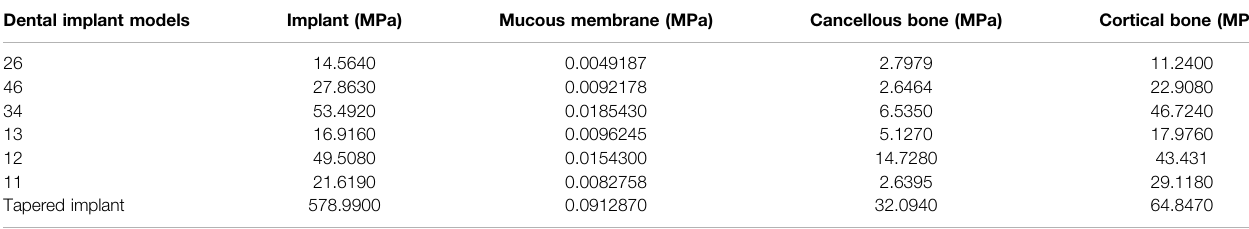
TABLE 3 | Maximum stress values when RAIs and tapered implant are subjected to 100-N horizontal load. Dental implant models